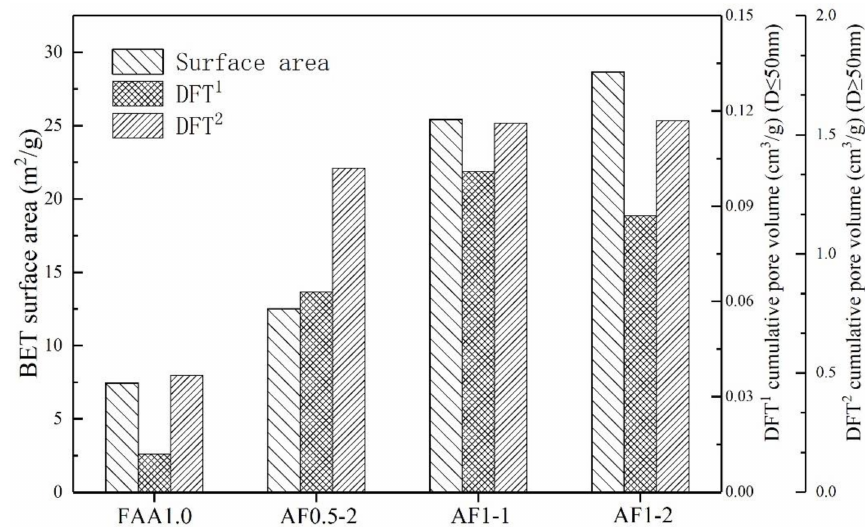
Figure 9. BET surface area and DFT cumulative pore volume characterization for FAA1.0, AF0.5-2, AF1-1, and